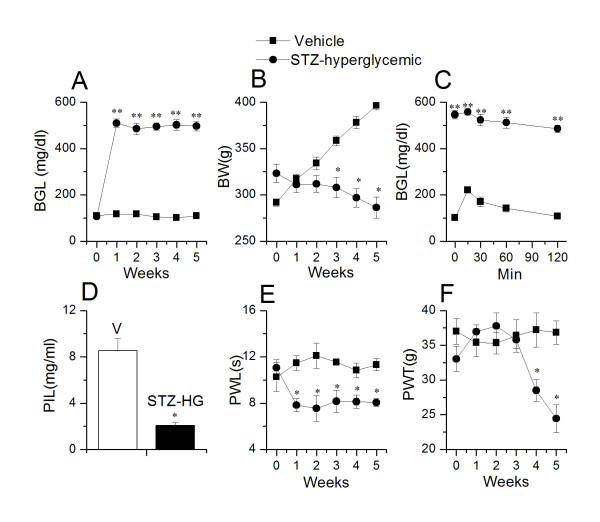
Changes in blood glucose levels, body weight, glucose tolerance, plasma insulin level, thermal pain sensitivity, mechanical allodynia in STZ-treated hyperglycemic (STZ-HG) rats. A. Within a week after intraperitoneal injection of STZ, blood glucose levels (BGL) significantly increased (p < 0.001) and remained constant throughout the course of the experiment as compared to vehicle-treated rats. B. The body weight of STZ-HG rats (filled circles, n = 18) decreased, whereas body weight of vehicle-treated rats (filled squares, n = 10) increased steadily over the course of 5 weeks. C. Glucose tolerance test (GTT) in STZ-HG and vehicle-treated rats 5 weeks after STZ administration. D. Plasma insulin levels were significantly lower (p < 0.05) in STZ-HG rats as compared to vehicle-treated rats. E. STZ-HG rats exhibited a significant decrease in PWL (p < 0.05) as compared to vehicle-treated rats. F. STZ-HG rats exhibited a significant (p < 0.05) decrease in PWT after 3 weeks of STZ administration as compared to vehicle-treated rats. Asterisks (*, **) represent p < 0.05 and p < 0.001, respectively.